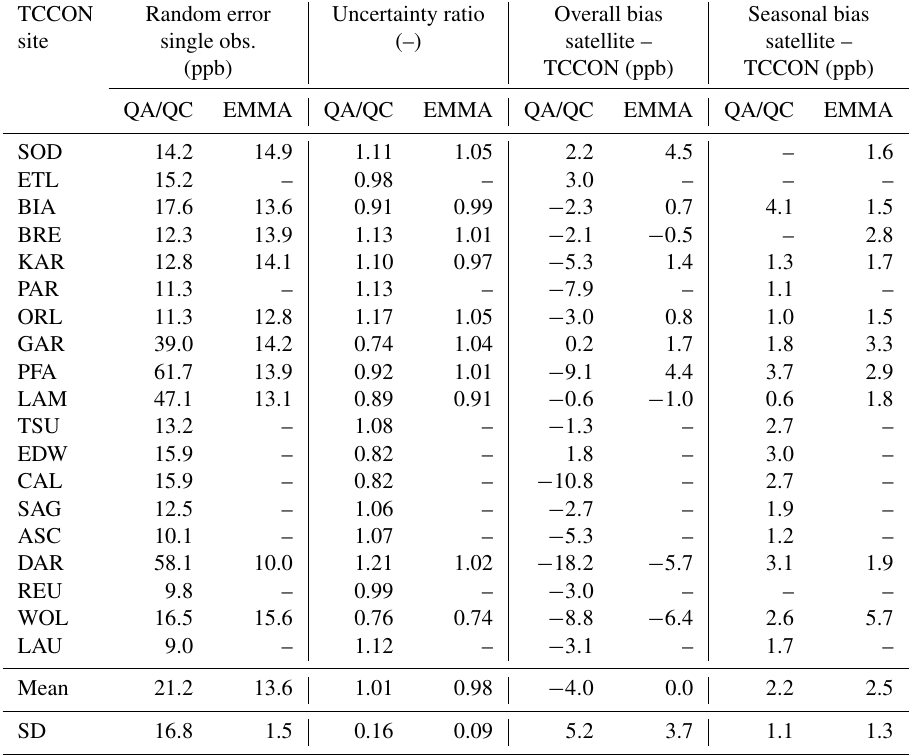
Table 7. Overview validation results at TCCON sites for data product XCH4_EMMA (version 4.1).